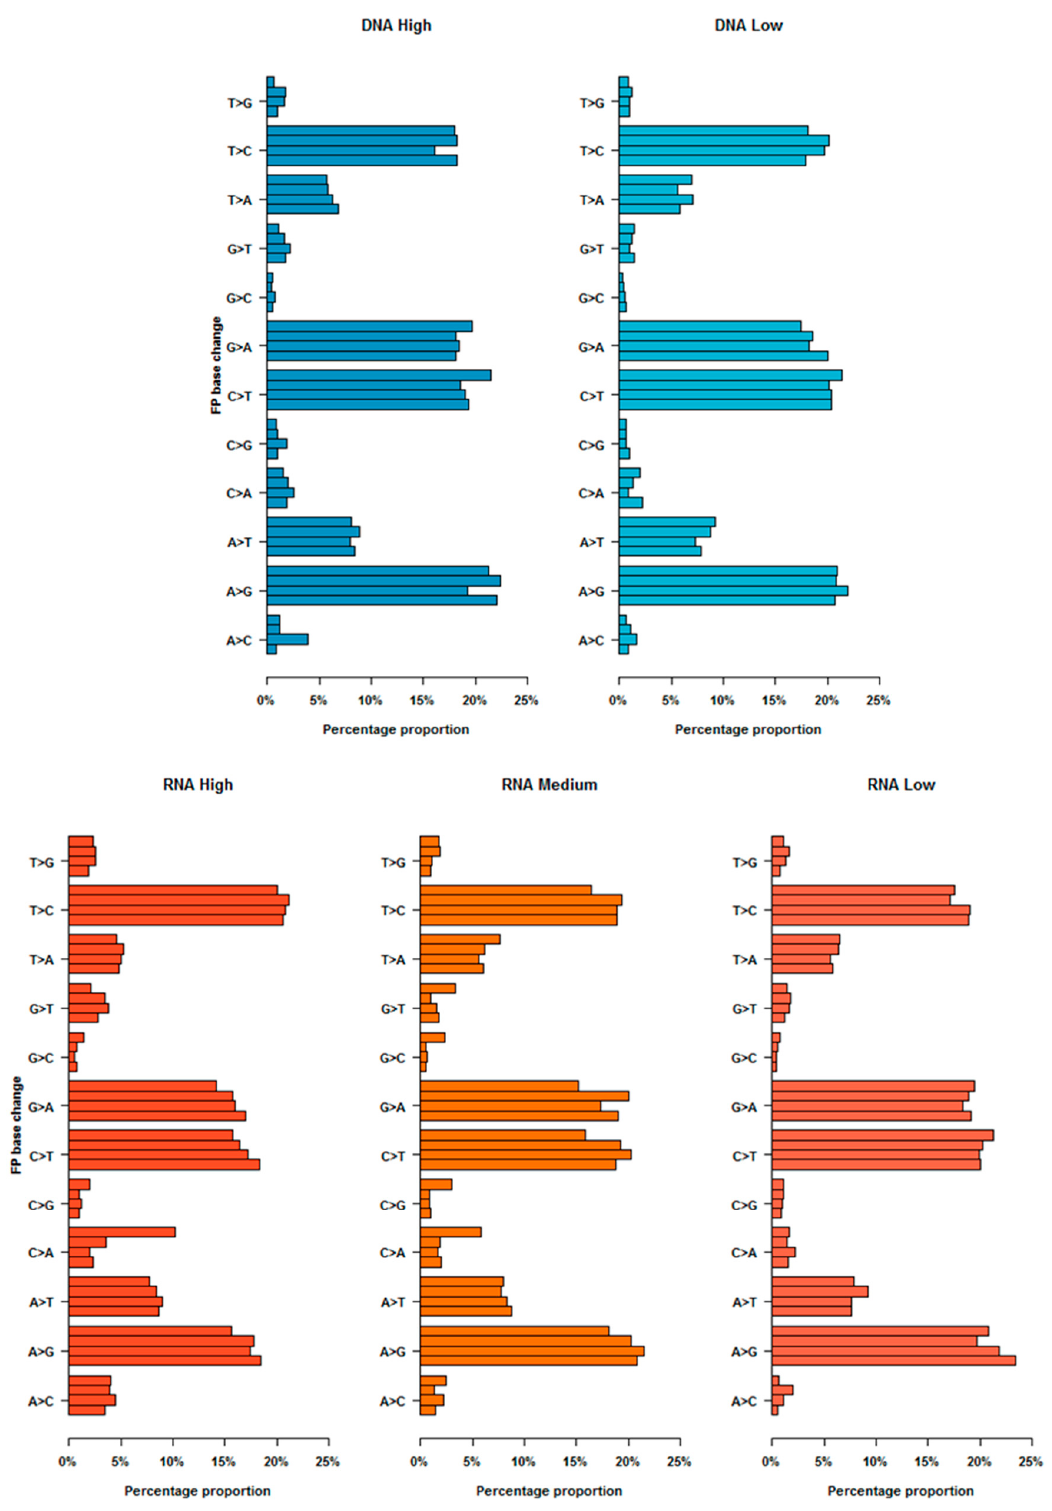
Figure 5. Identification of nucleotide substitutions which arose from processed-introduced error. All error base changes (from all frequency cut-offs tested) from each sequenced technical replicate (represent by each of the 4 bar plots in each base change) for each population type were analysed. Regardless of genomic type and abundance, four main False Positive (FP) base changes (represented > 10% of all FP types) were characterized in each of the four technical replicates.